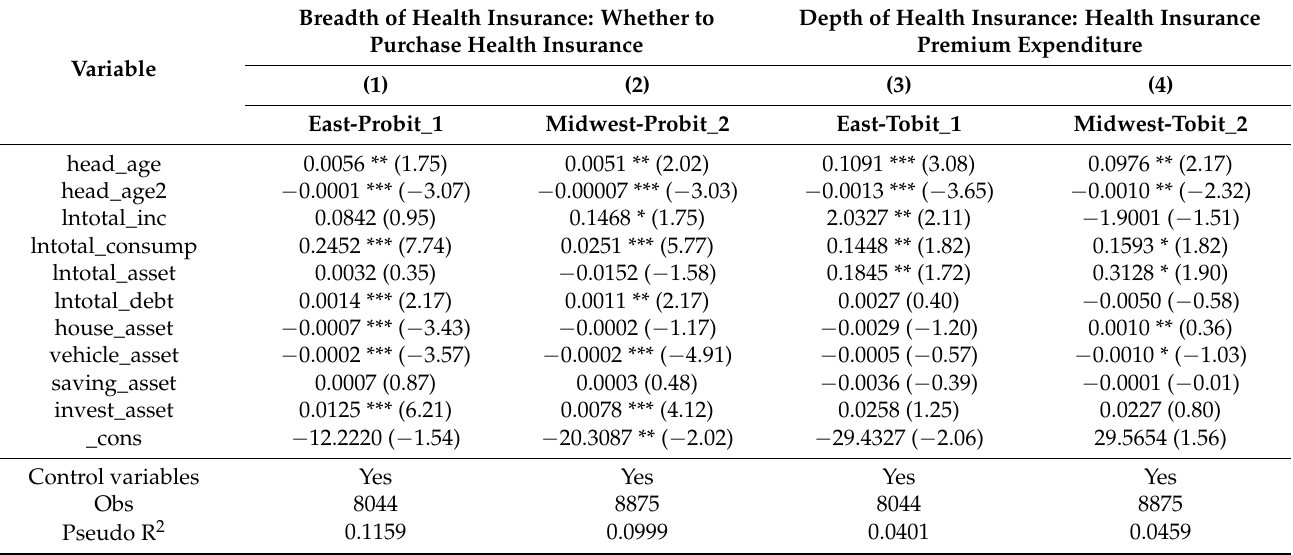
Table 10. Model estimation results under sub-samples divided by region